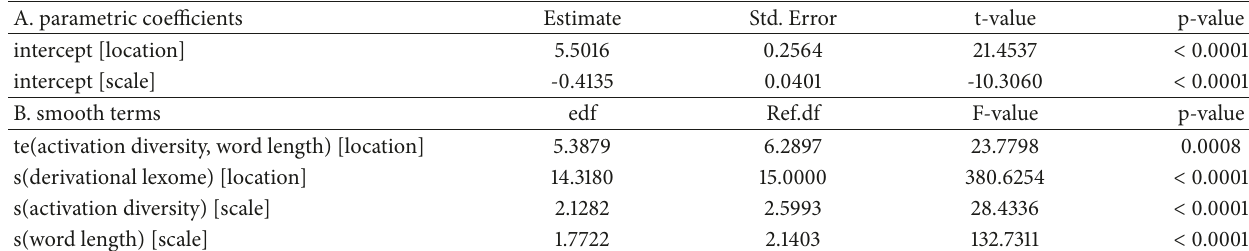
Table 4: Gaussian location-scale additive model fitted to the semantic transparency ratings for derived words. te: tensor product smooth and s: thin plate regression